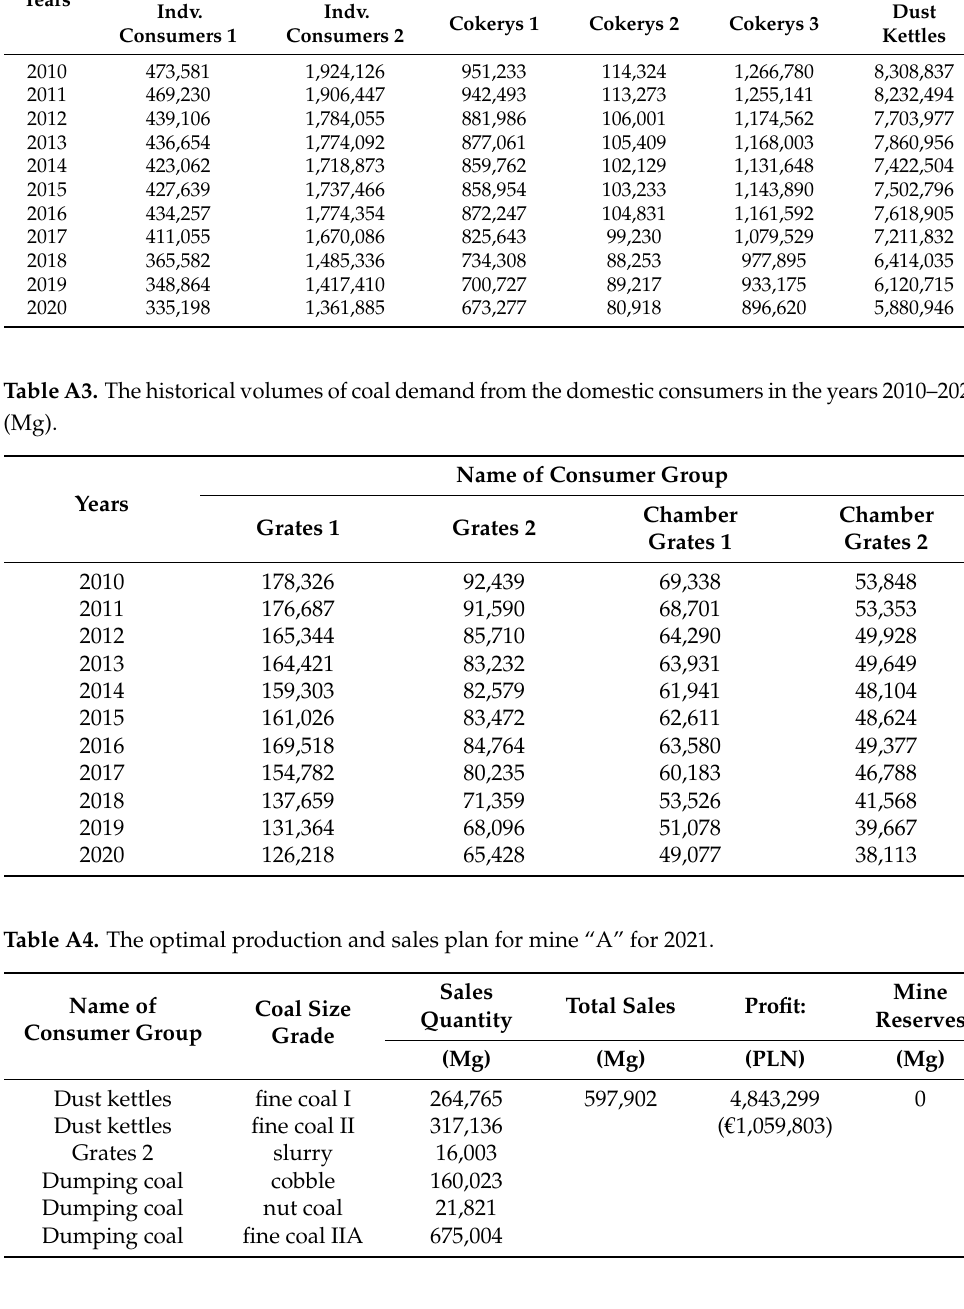
Table A5. The optimal production and sales plan for mine “B” for